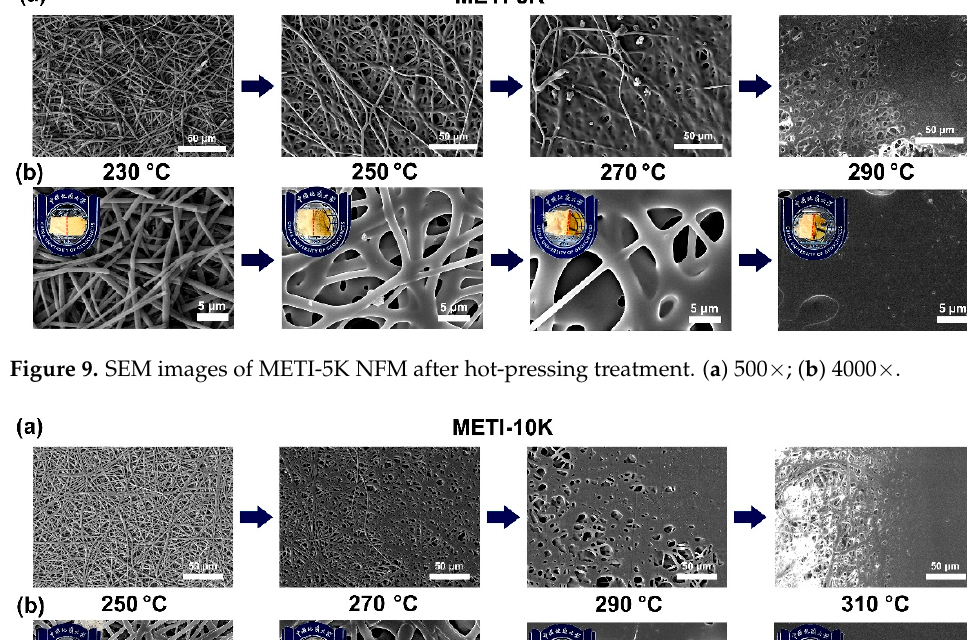
Figure 11. SEM images of METI-20K NFM after hot-pressing treatment. ( a ) 500×; ( b )